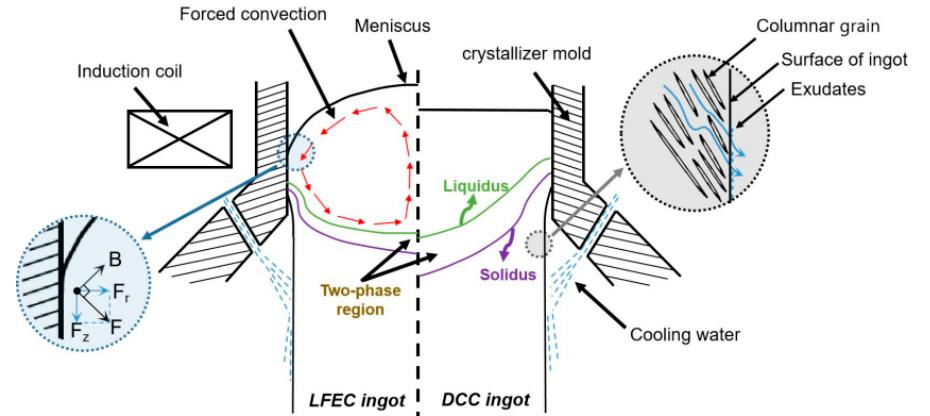
Figure 14. Schematic diagrams of the solidification.